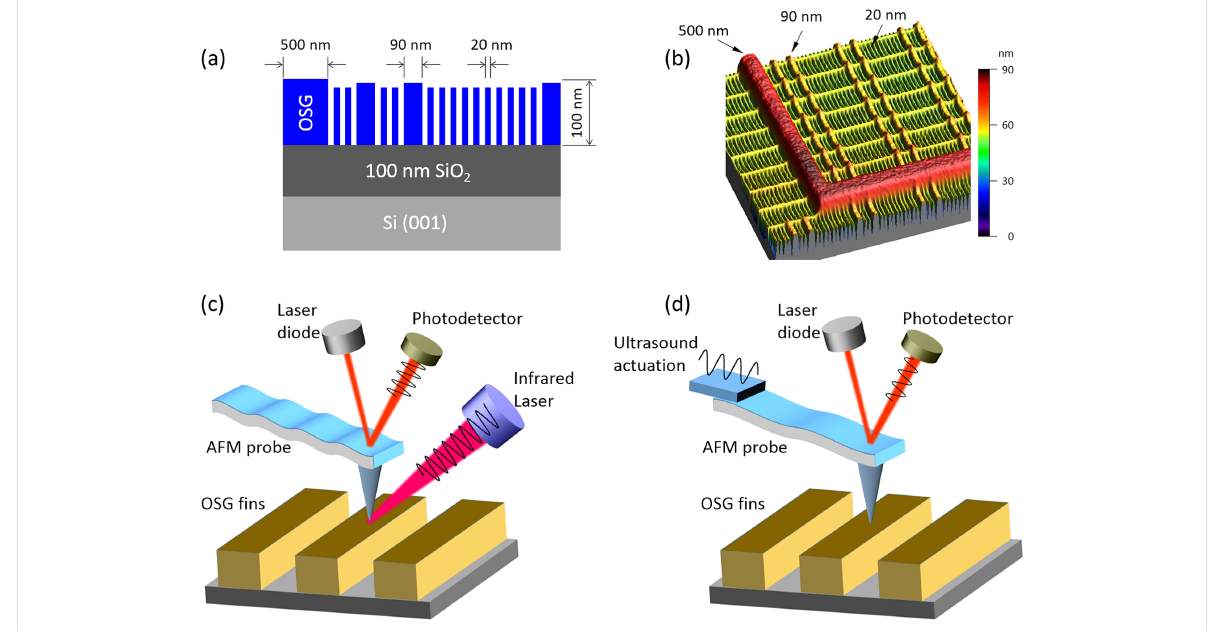
Figure 1: (a) Cross section schematic of the nanoporous organosilicate glass (OSG) fin structures investigated in this study. (b) AFM image (5 µm × 5 µm) of the surface topography of the actual structures investigated. (c) Schematic diagram of the AFM-IR measurements on the OSG fins. (d) Schematic diagram of the CR-AFM measurements on the OSG fins. Both (c) and (d) cartoons are drawn at relative scales to highlight the differ- ences between the two techniques, with the impulse of the rapid sample expansion due to IR absorption causing a resonant oscillation of the AFM cantilever in AFM-IR (c) and the tip–sample contact mechanically vibrated at ultrasound frequencies in CR-AFM